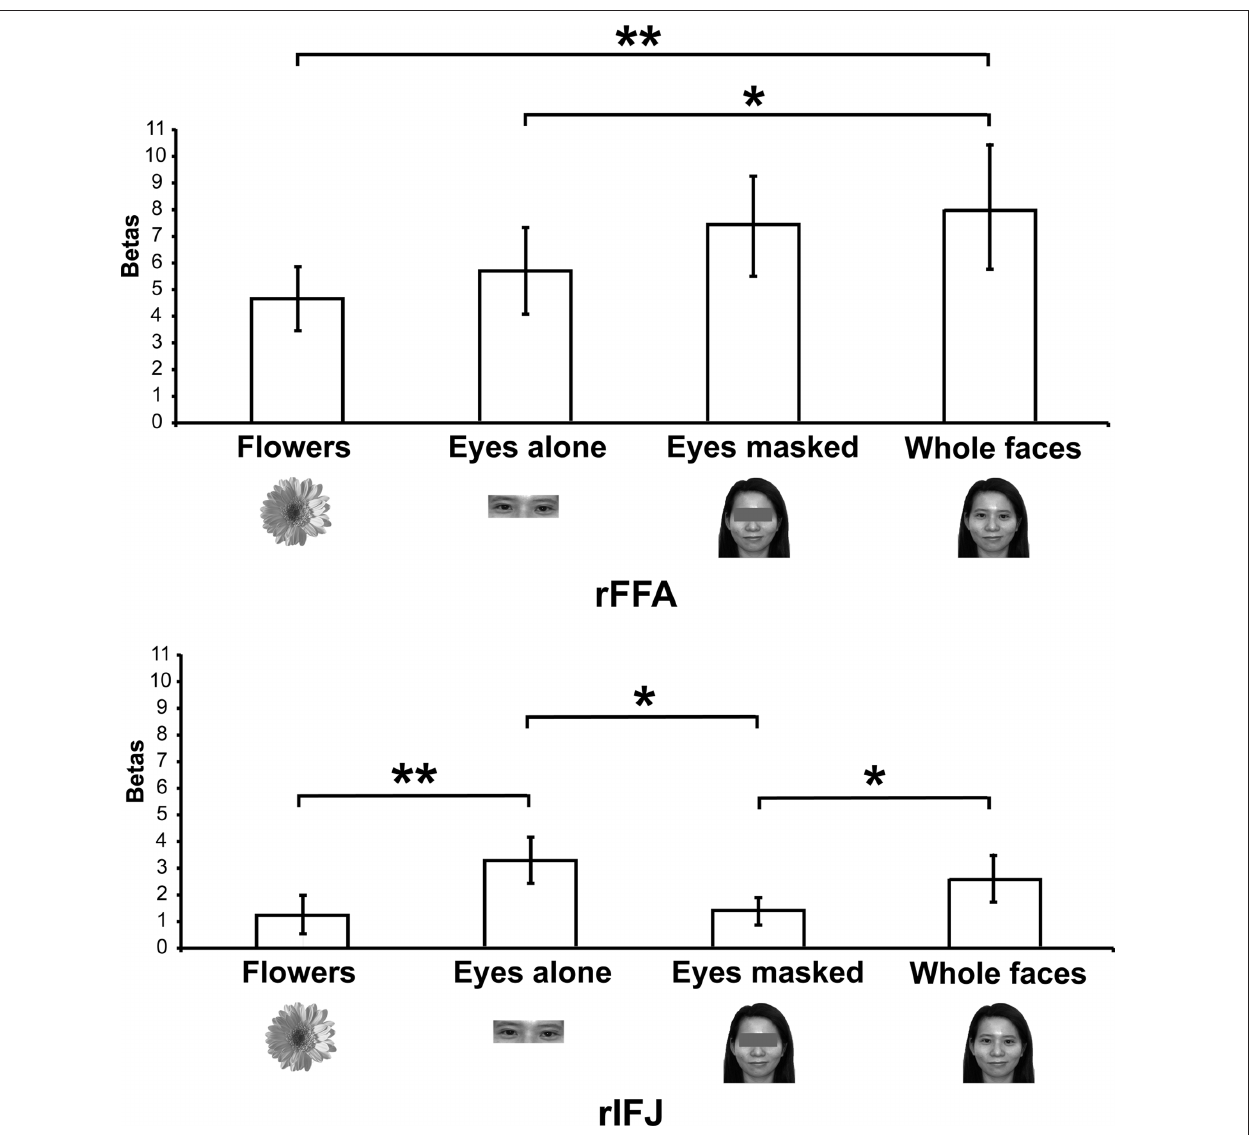
FIguRe 3 | Results of experiment 2. Responses of rFFA and rIFJ, based on independent functional localizers, to flowers, whole faces, eyes, and faces with eyes masked. Conventions as in Figure 2 . Asterisks indicate significant differences between conditions: * p < 0.05; ** p